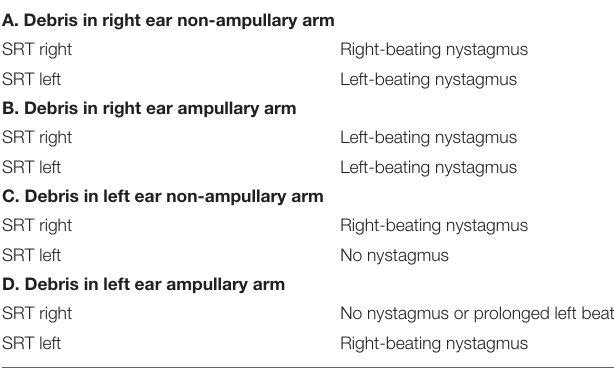
TABLE 3 | Supine roll test interpretations of hc-canalithiasis on starting the SRT by turning to the right first. A. Debris in right ear non-ampullary